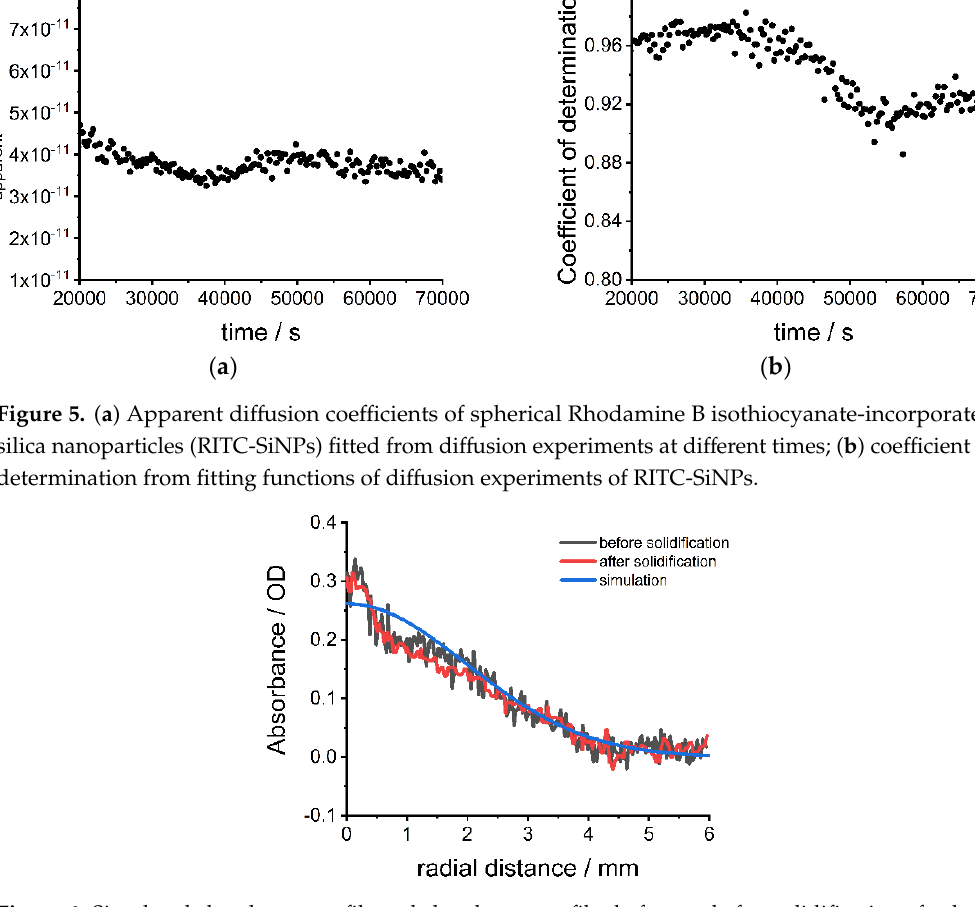
Figure 6. Simulated absorbance profile and absorbance profiles before and after solidification of gelatin nanoparticle gradient material with RITC-SiNPs at λ = 550 nm. Radial distance is the distance from the top of the melt/material.